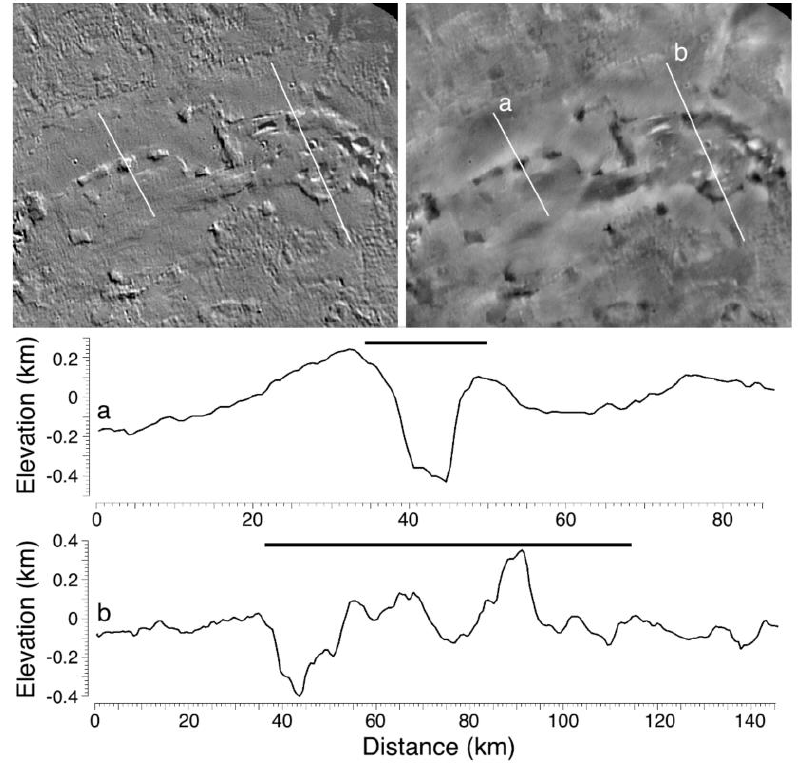
Figure 18. Topographic profiles across pits in Set Catena pit chain and broad shallow depression at eastern end. ( Top ) Image mosaic and ( right ) DEM scene widths are ~280 km, from SG-PC-DEM in Figure 8. Note different horizontal scales in